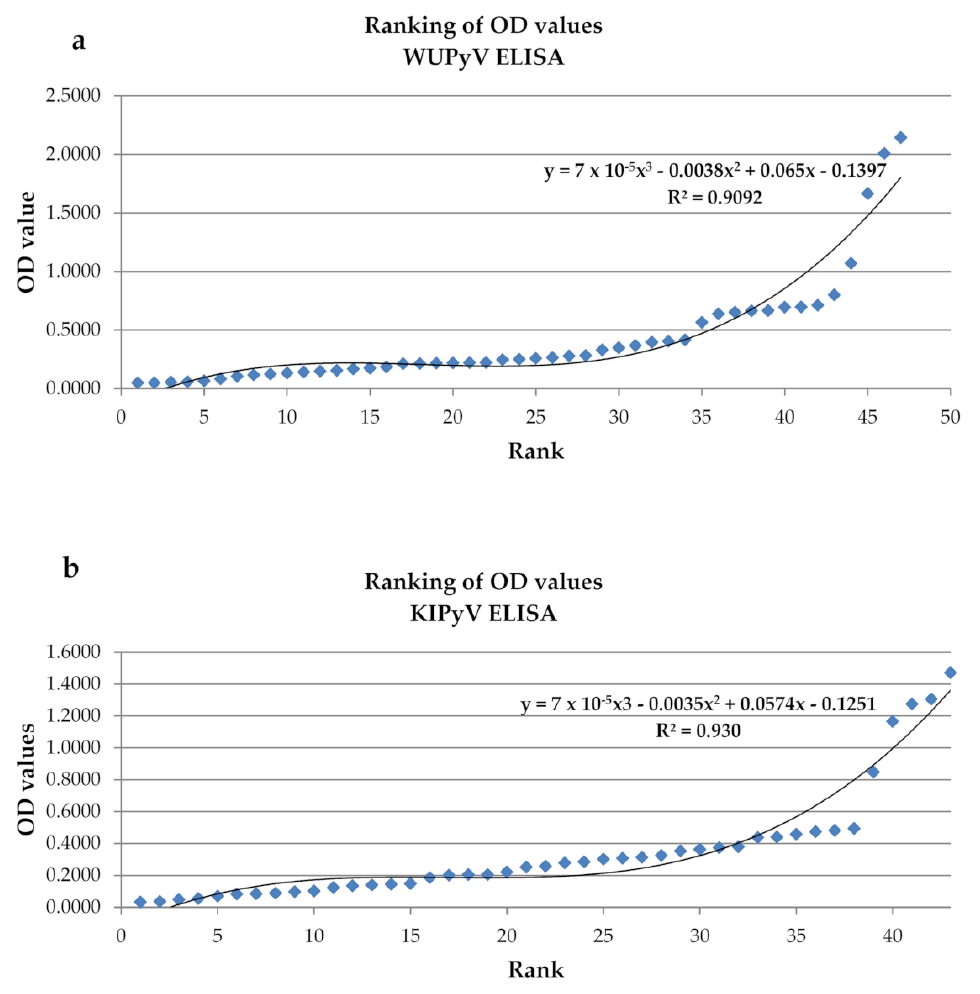
Figure 1. Ranking the optical density (OD) values of patients <3 years old measured in the ( a ) KIPyV and ( b ) WUPyV enzyme-linked immunosorbent assay (ELISA). Diamonds represent each OD value. The polynomial trend line is the line of best fit; the correlation coefficient (R 2 ) and the function used to calculate the inflection point are indicated. KIPyV, KI polyomavirus; WUPyV, WU